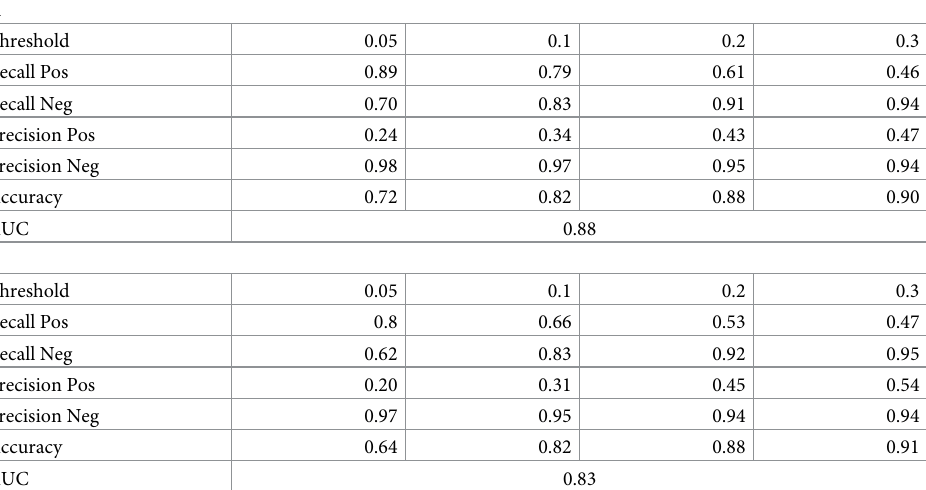
S1 Table. Data dictionary. Data dictionary of each data element used in the model. (PDF) S2 Table. Disease onset model rules. The following table reports the probabilistic weights for each rule of the symptom onset forecasting model.